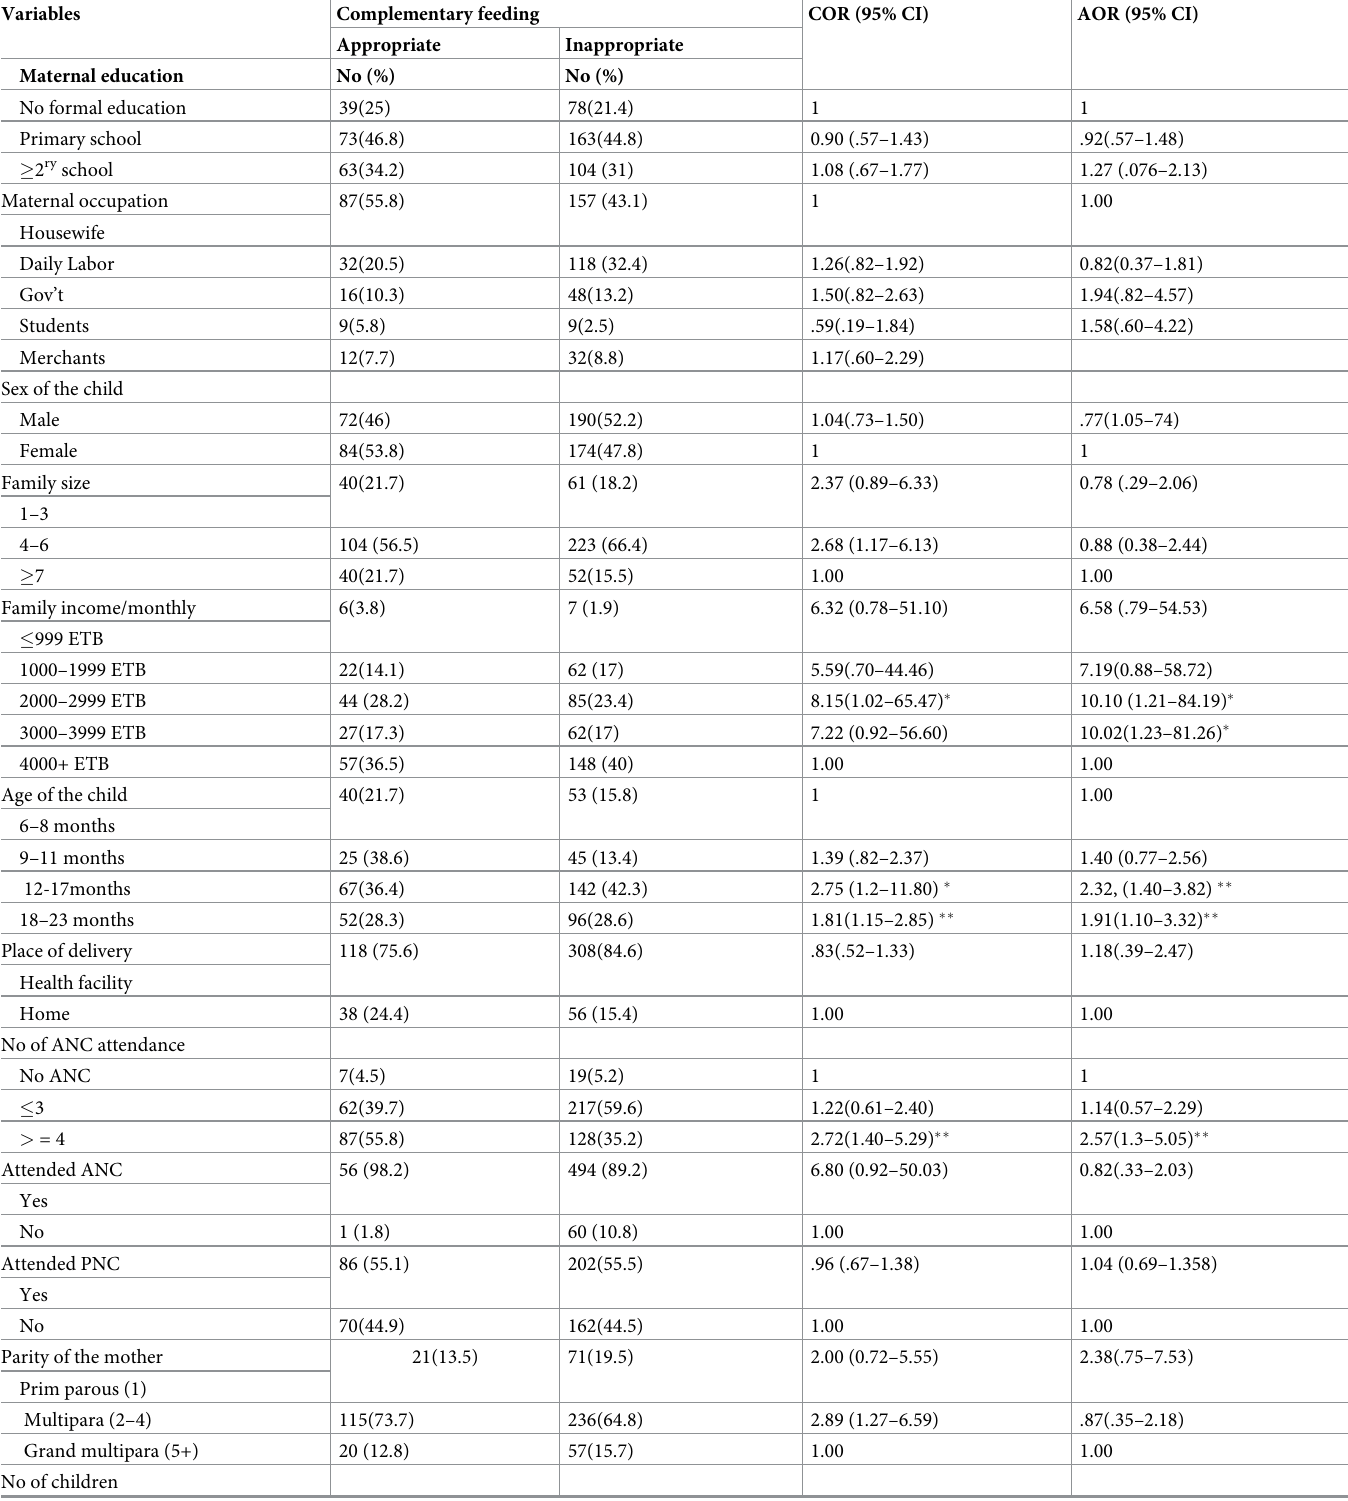
Table 4. Factors associated with complementary feeding of children age 6–23 months, Shashamene -Oromia, Ethiopia,